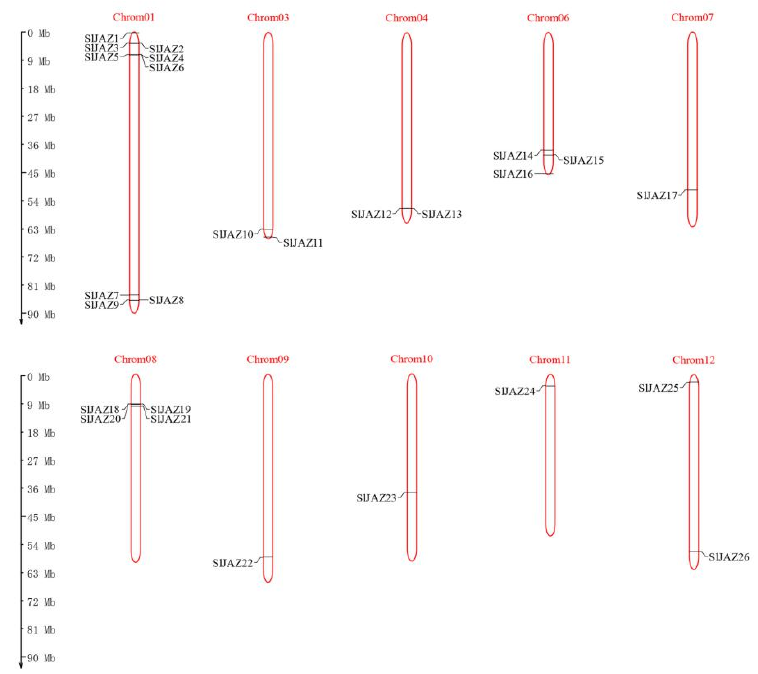
Figure 1. Chromosomal distribution of tomato JAZ genes ( SlJAZs ). Chromosomes without SlJAZ genes are not shown. The length of the chromosome can be estimated using the scale on the left.